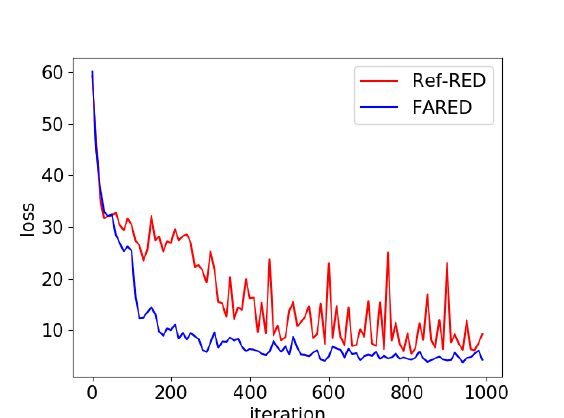
Figure 7. Comparison of Ref-RED and FARED training process. It shows that loss of the FARED converges faster and more stable than Ref-RED under same conditions (1 k iterations with minibatch size 100 of training and 0.005 of learning rate).